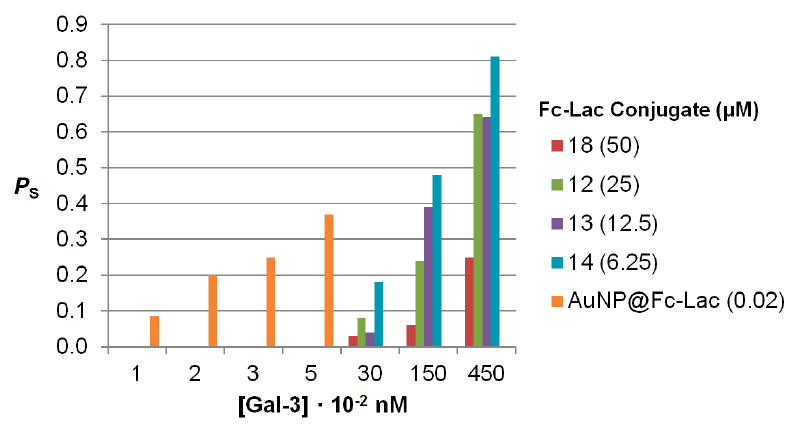
Figure 9. Sensitivity parameters ( P s ) for ferrocene–lactose conjugates 12 – 14 , 18 , and AuNP@Fc-Lac with increasing concentrations of Gal-3.